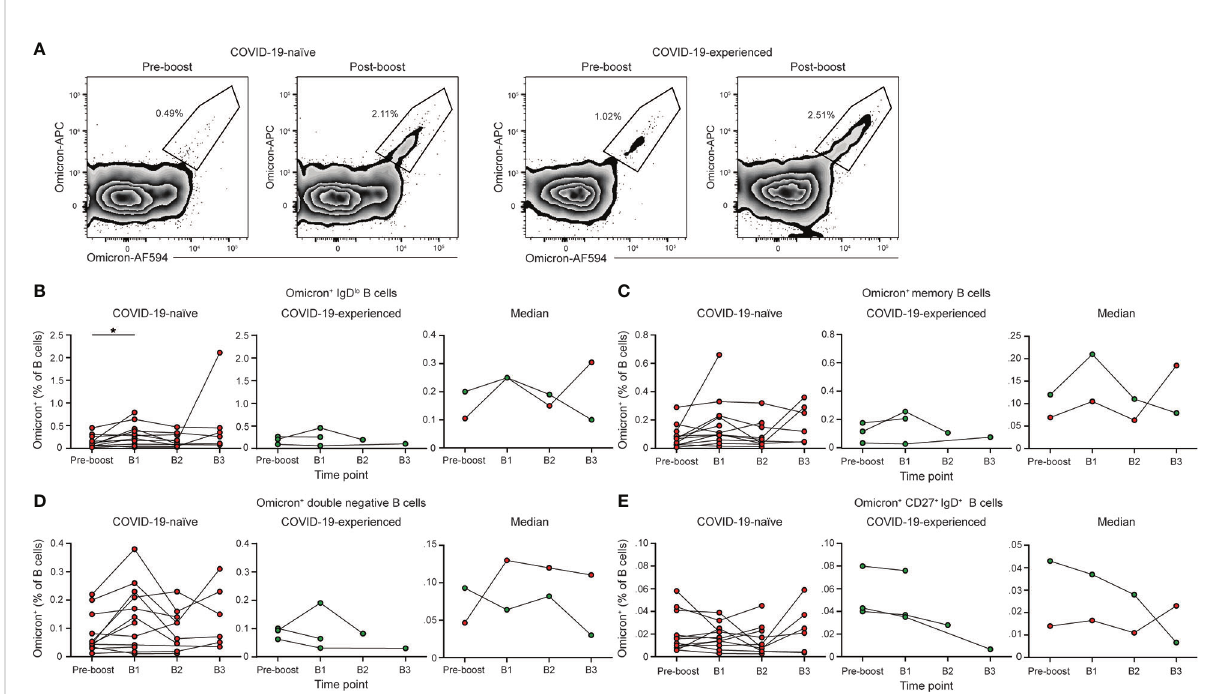
FIGURE 5 PAD patients have elevated Omicron-speci fi c B cell responses following booster vaccination. (A) Representative fl ow cytometry plots of the percentage of Omicron-speci fi c B cells among the memory (IgD lo CD20 + CD38 int-lo CD27 + ) B cell population prior to and post booster vaccination in COVID-19-naïve (left) and -experienced (right) individuals with PAD syndromes. Percentage of (B) IgD lo , (C) memory, (D) double negative (IgD lo CD20 + CD38 int-lo CD27 - ), and (E) IgD + CD20 + CD38 int-lo CD27 + Omicron + cells among the B (Live CD19 + CD3 - ) cell population in healthy donors (left, white), COVID-19-naïve PAD (middle left, red), and COVID-19-experienced PAD (middle right, green) cohorts. Median percentage of B cells that comprise each population in all groups is shown on right. Statistical analyses in (B – E) were performed using a mixed effects model (for trends found between time points) or two-way ANOVA (for trends found between groups shown on the median graphs) with Fisher ’ s least signi fi cant difference testing. Signi fi cance testing between time points was limited to comparisons relative to pre-boost. Above the median graphs, an orange asterisk indicates a comparison between the COVID-19-naïve and -experienced groups (* p < 0.05). See also Figure